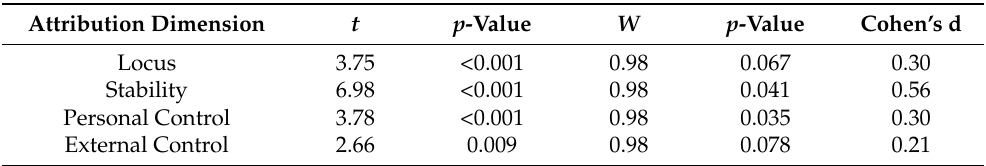
Table 4. Two-tailed Paired Samples t -test, Cohen’s d, and Shapiro–Wilk test ( W ) results for Success Compared to Failure for Each Attribution Dimensions ( N =